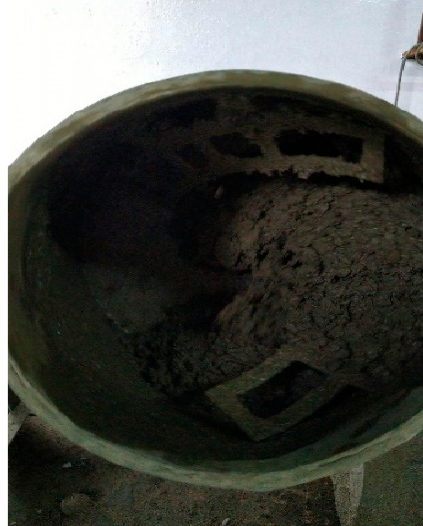
Figure 9. Mixing of CFA-based concrete.